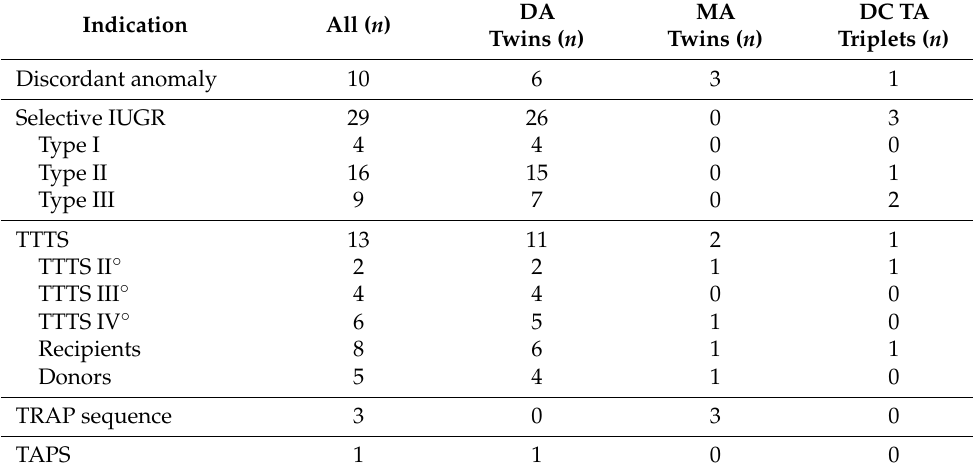
Table 1. Five groups according to indication for selective